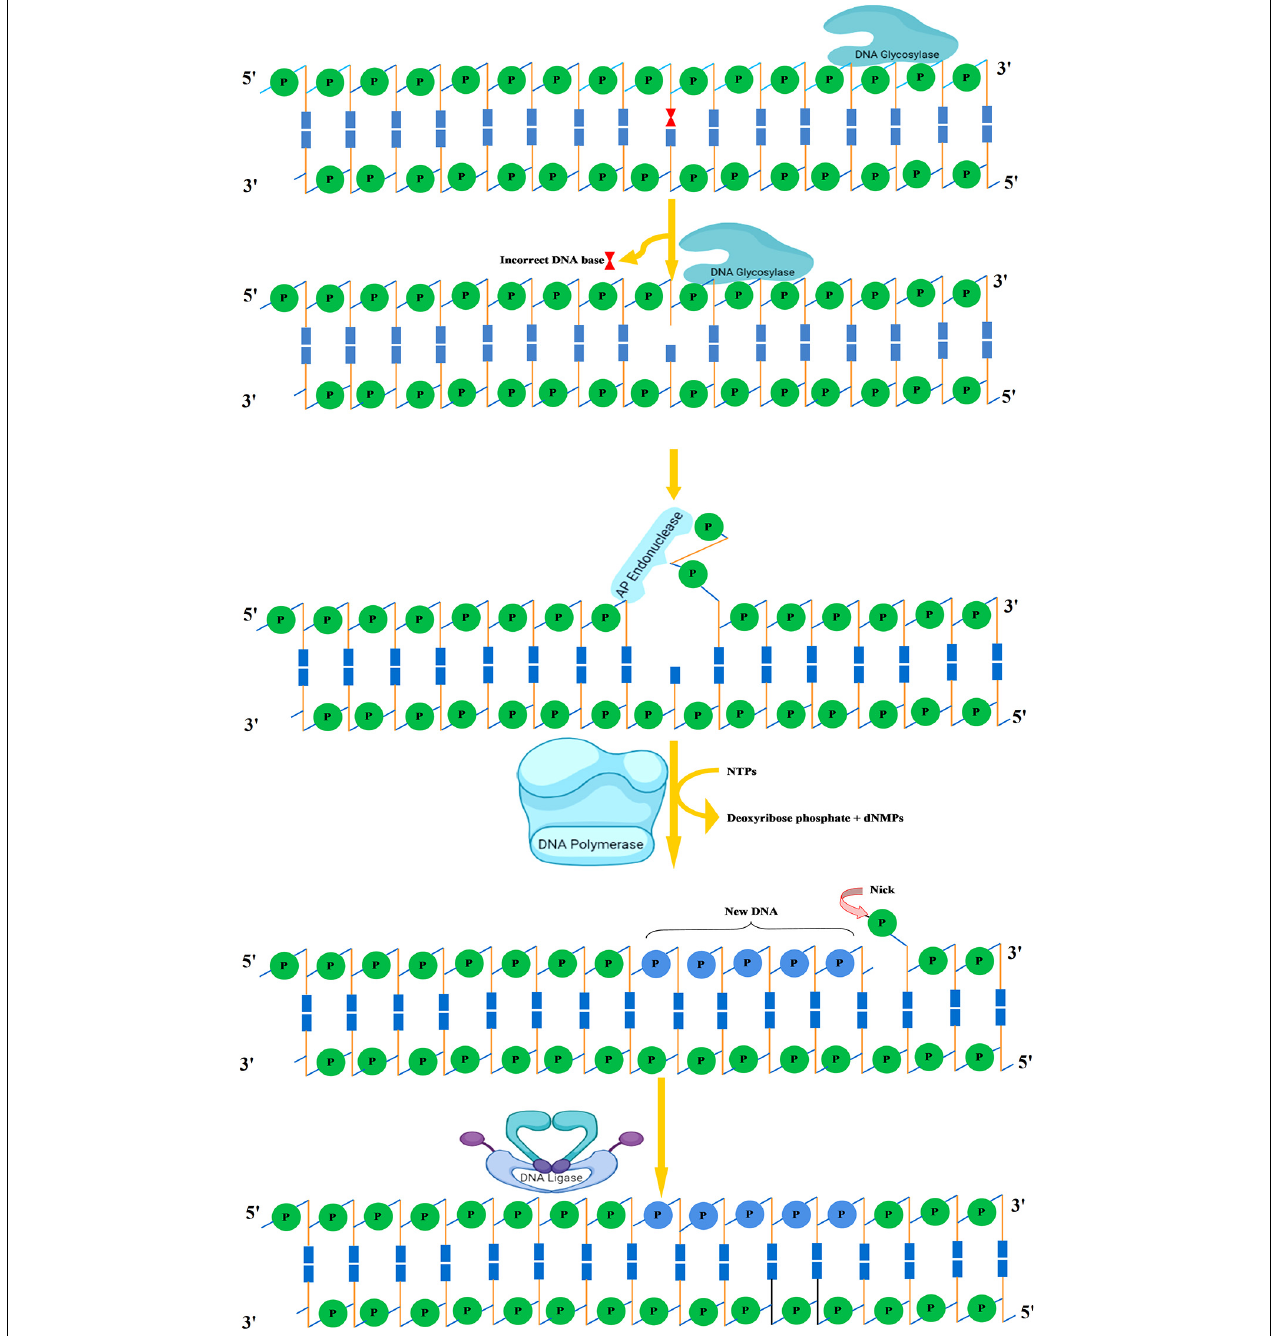
FIGURE 6 | Base excision repair. Recognition followed by removal of damaged DNA base by DNA glycosylase resulting in the formation of AP site. An AP endonuclease nicks the phosphodiester backbone near the AP site. DNA polymerase I replaces the damaged portion with a new DNA. Finally, DNA ligase seals the nick. AP,